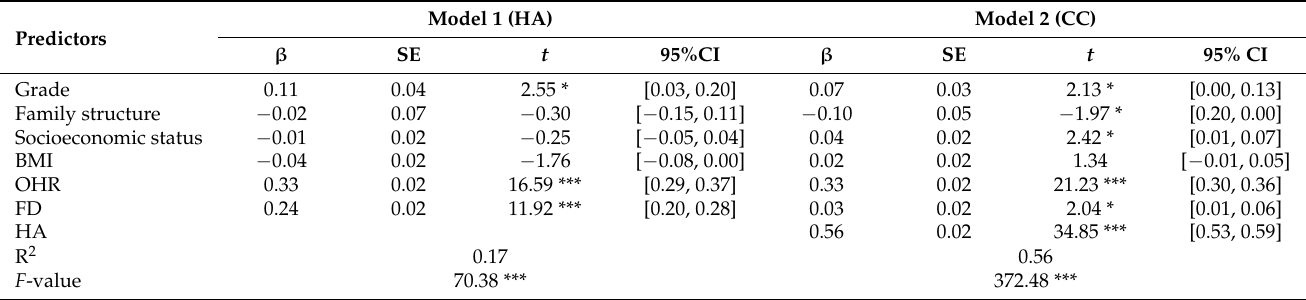
Table 3. The Mediation Effects of Family Dysfunction on Cyberchondria.